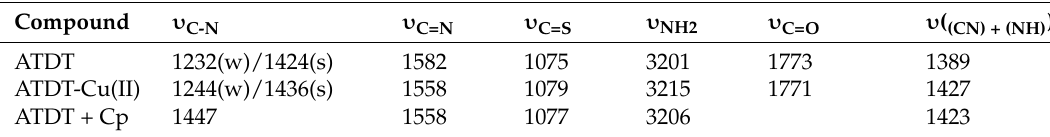
Figure 7. The Fourier Transform Infrared Spectroscopy (FT-IR) spectra of the ( a ) ATDT, ATDT-Cu complexes, chalcopyrite before and after treatment; and ( b ) ATDT, molybdenite before and after treatment. Table 2. Important IR spectra bands of depressant, Cu (II) complexes and depressant treated chalcopyrite (cm − 1 ).